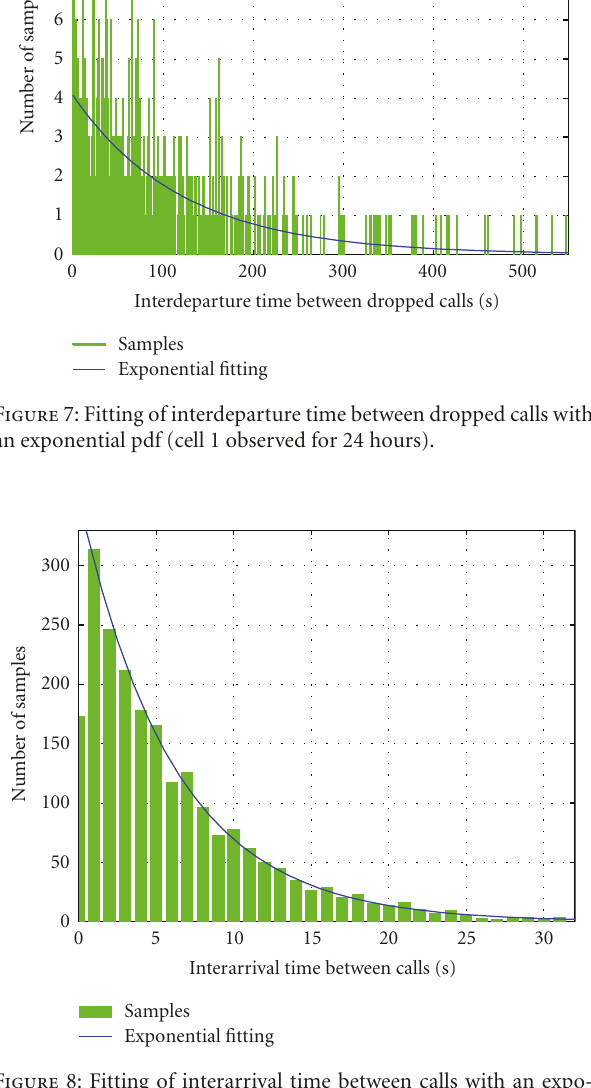
Figure 6: Fitting of conversation duration of dropped calls with a lognormal pdf (cell 1 observed for 4 hours).